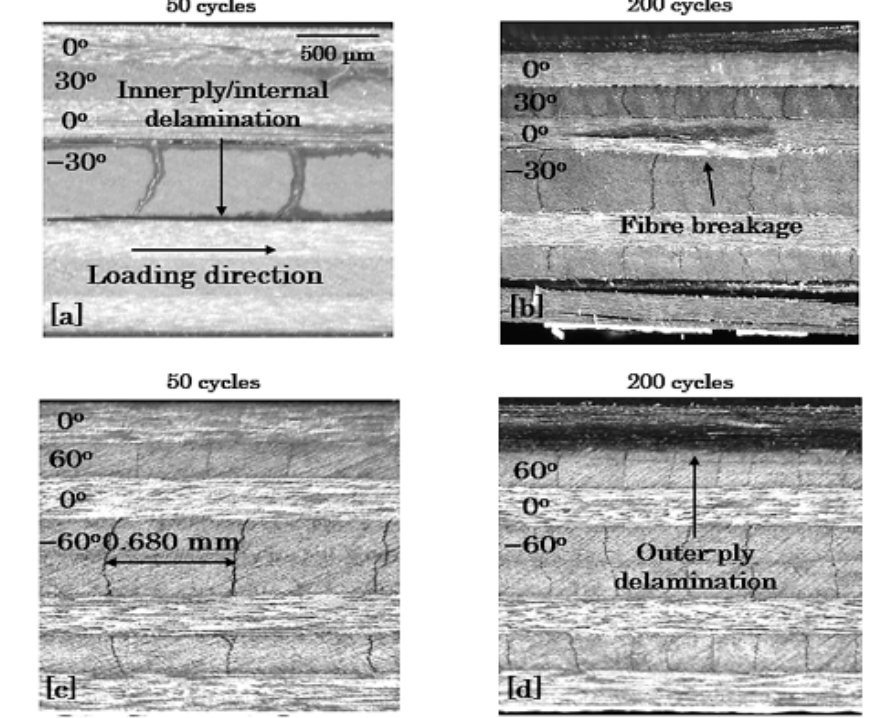
Figure 19. Damage in [0°/30°/0°/ − 30°] s (top) and [0°/60°/0°/ − 60°] s (bottom) laminates after ( a , c ) 50 and ( b , d ) 200 cycles for σ max = 0.8 × σ ult and R = 0.1.